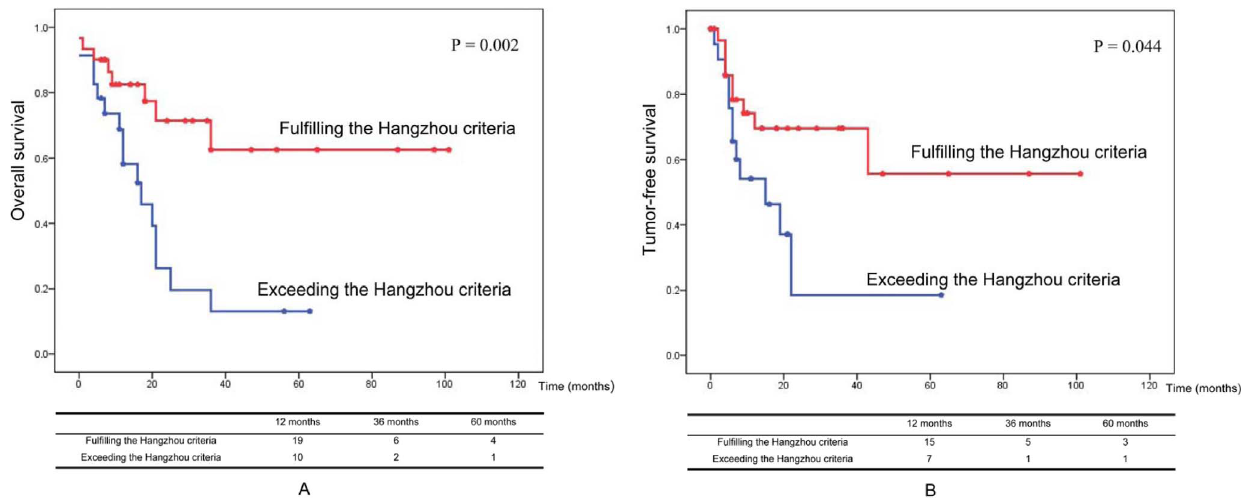
Figure 2. The Hangzhou criteria differentiated between recipients of salvage liver transplantation. A) overall survival, B) tumor-free survival.